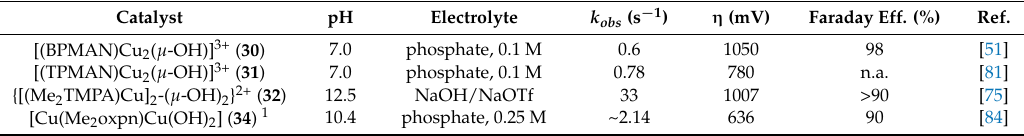
Table 3. Kinetic, electrochemical data and reaction conditions of dicopper water oxidation catalysts. Catalyst